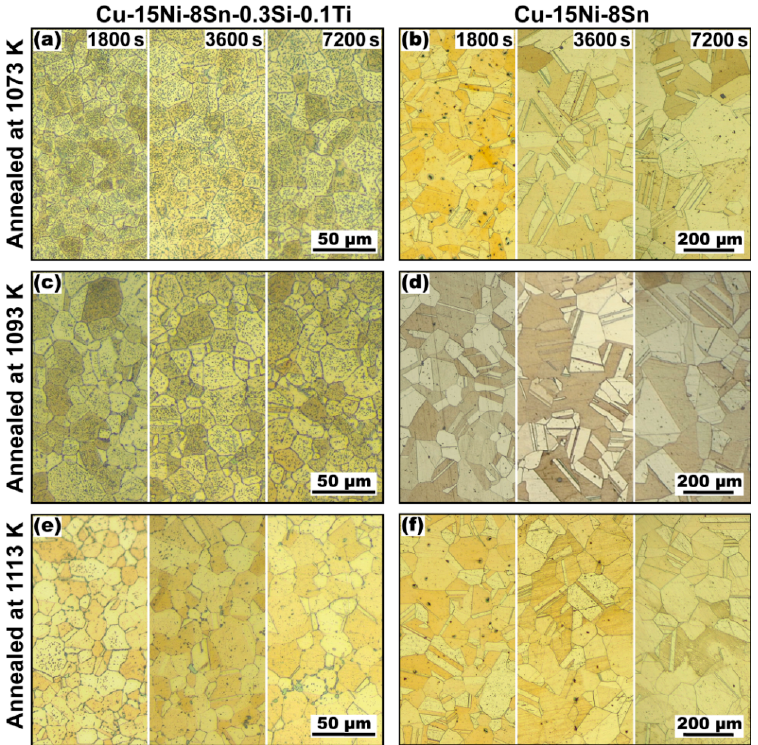
Figure 2. Representative optical images of the microstructure of the studied materials after annealing in different conditions: ( a , c , e ) Cu-15Ni-8Sn-0.3Si-0.1Ti; ( b , d , f ) Cu-15Ni-8Sn.